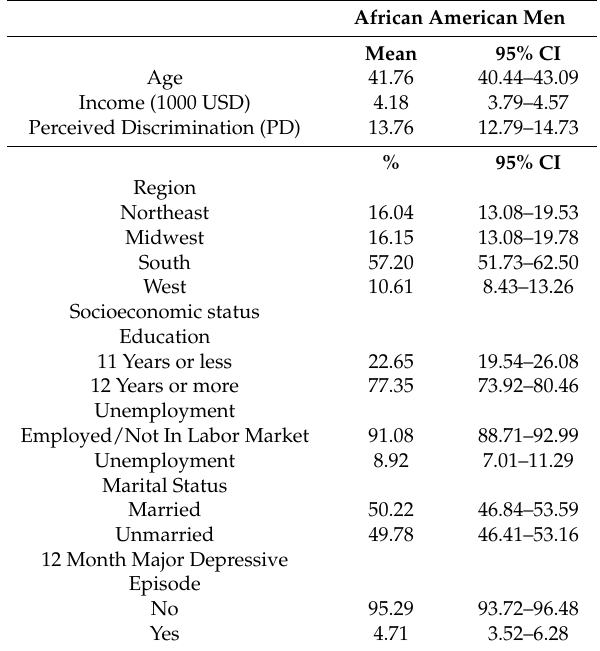
Table 1. Summary of descriptive statistics in African American